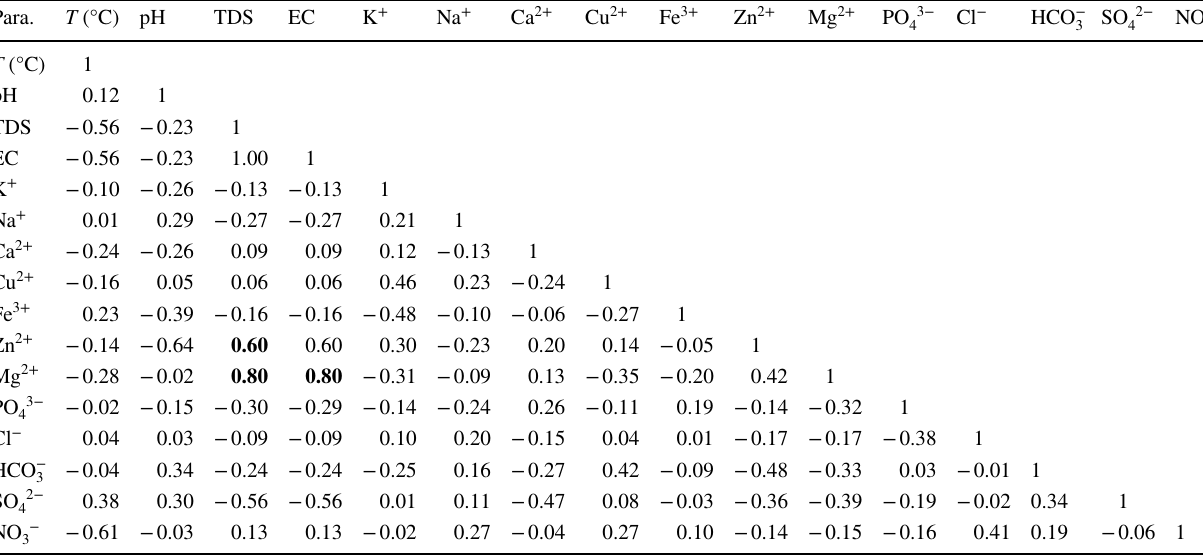
Table 7 Correlation matrix of physicochemical parameters of deep groundwater 0.50Para. Values in bold are significant at ≥ Table 8 Correlation matrix of physicochemical parameters of shallow groundwater